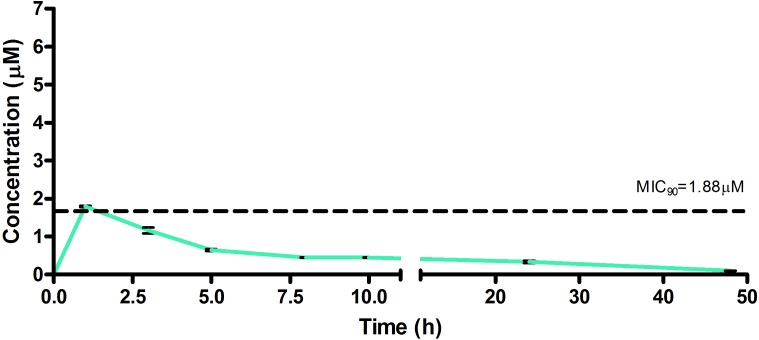
Total concentrations for RMB073 following oral administration in an uninfected murine model.